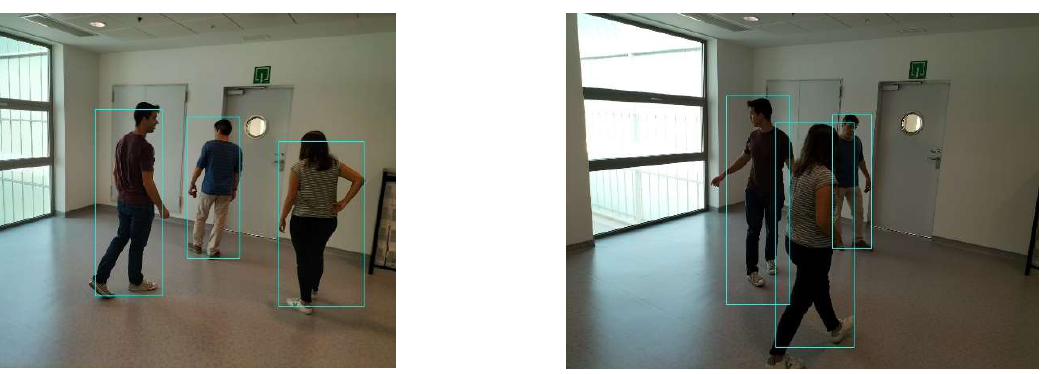
Figure 7. Setup scenario and person detection results obtained with the I.MX8M Plus-based embed- ded board. Left , non-overlapped persons detected. Right , overlapped persons detected.